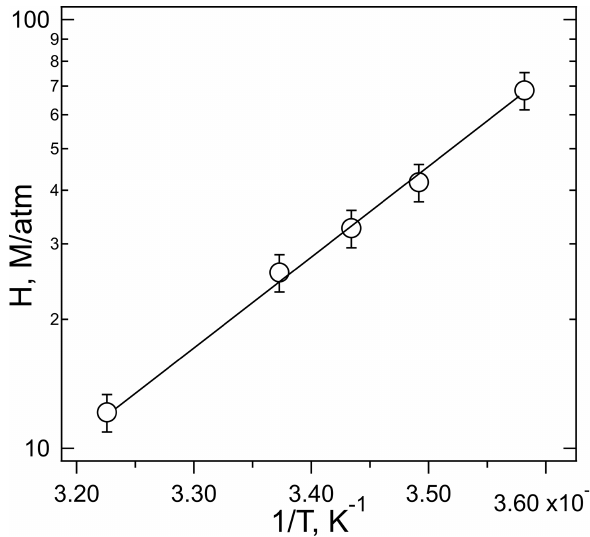
Figure 5. The plot of ln H eff versus 1 /T for the experiments per- formed with HNCO at pH = 3. R 2 = 0 .